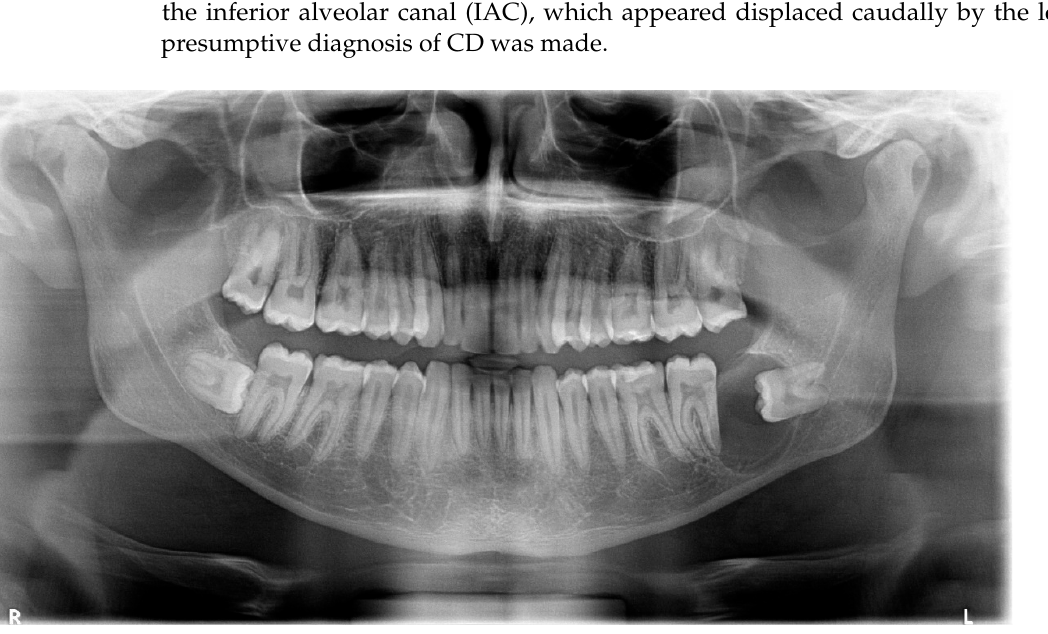
Figure 1. Panoramic X-ray of case